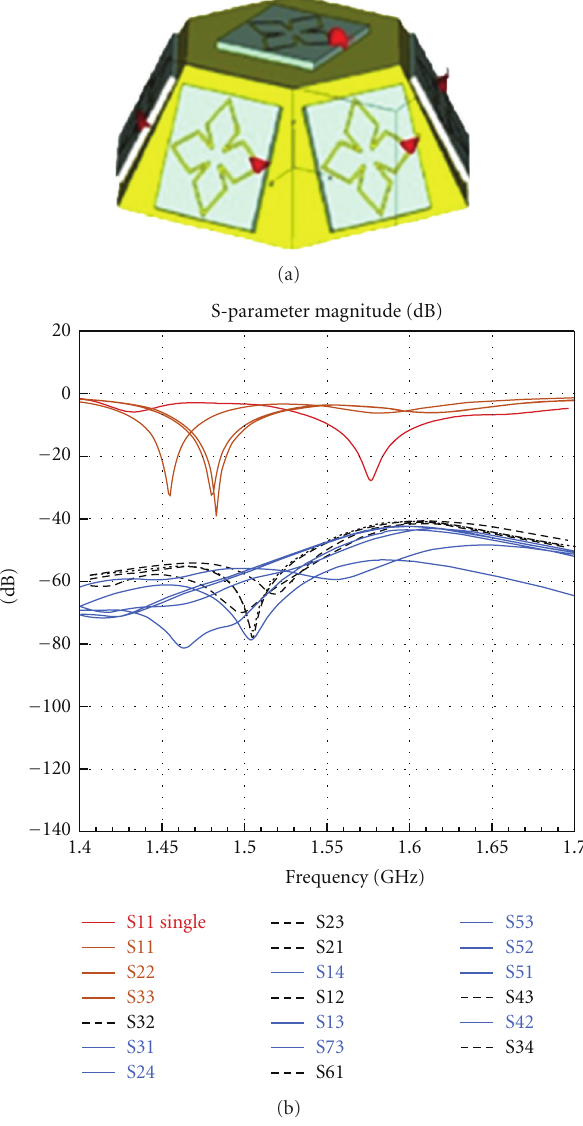
Figure 6: (a) Hexagonal pyramid conformal array and (b) its S-